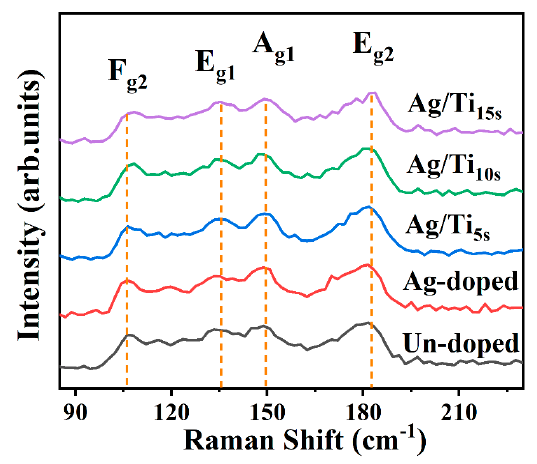
Figure 2. The Raman patterns for Ag/Ti co-doped CoSb 3 , the un-doped and single Ag-doped thin films.